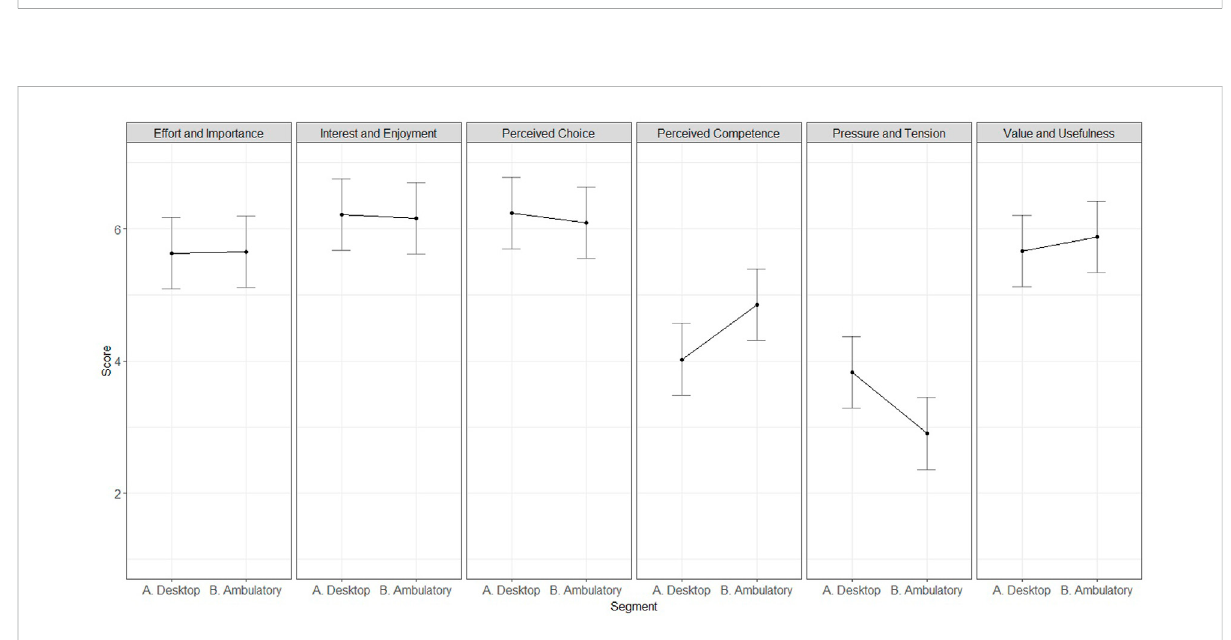
Frontiers in Virtual